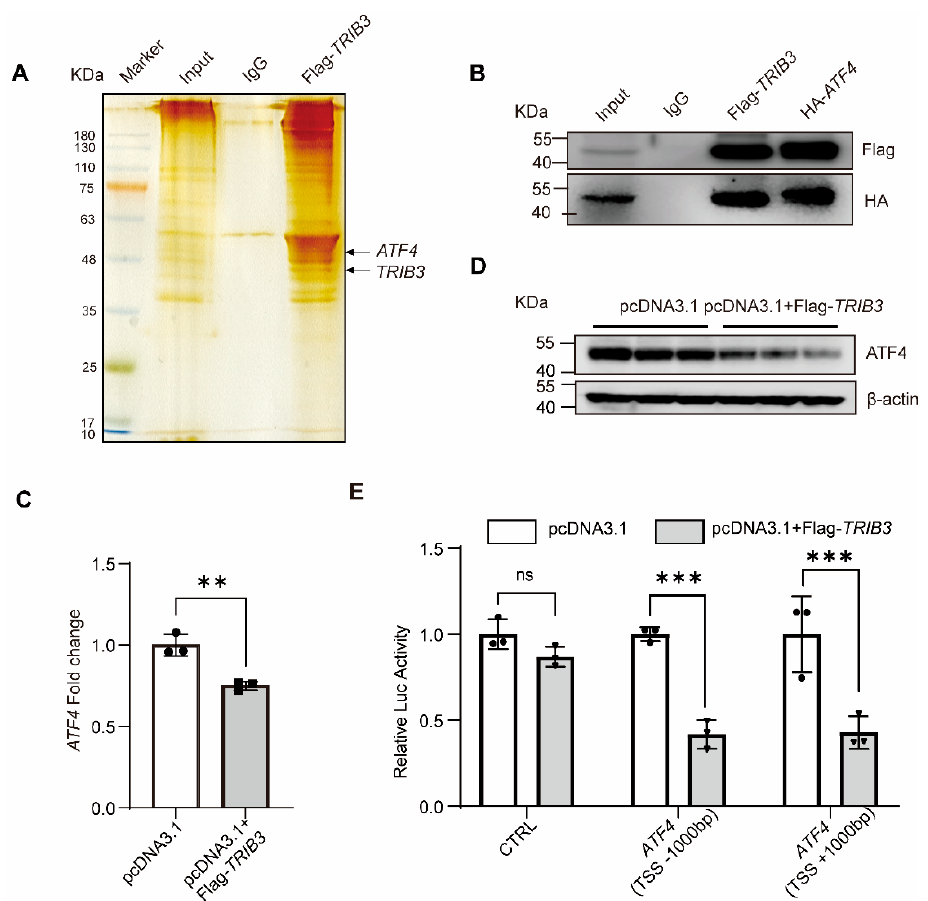
Figure 5. TRIB3 interacts with ATF4 and negatively regulates ATF4 . ( A ) Immunoprecipitation for TRIB3 in MRC5 cells. TRIB3 interacts with ATF4 by silver staining. ( B ) Co-IP of flag-tagged TRIB3 and HA-tagged ATF4 protein from the transfected cell lysates. ( C , D ) Overexpression of TRIB3 decreased the expression of ATF4 both at RNA and protein levels (N = 3 independent experiments). GAPDH was used as an internal control for qPCR, and β -actin was used as an internal control for western blot. The results were analyzed by the unpaired Student’s t -test for comparisons between two groups with normal distribution. Data are presented as mean ± SD. ** p < 0.01. ( E ) Relative expression of ATF4 promoter-driven luciferase reporters in TRIB3 -overexpressing cells (N = 3 independent experiments). Results were normalized to Renilla luciferase activity and expressed as relative luciferase units. Significant differences between groups were evaluated by two-way ANOVA with Šídák’s multiple comparisons test for pairwise comparisons. *** p < 0.001. ns, no significance.